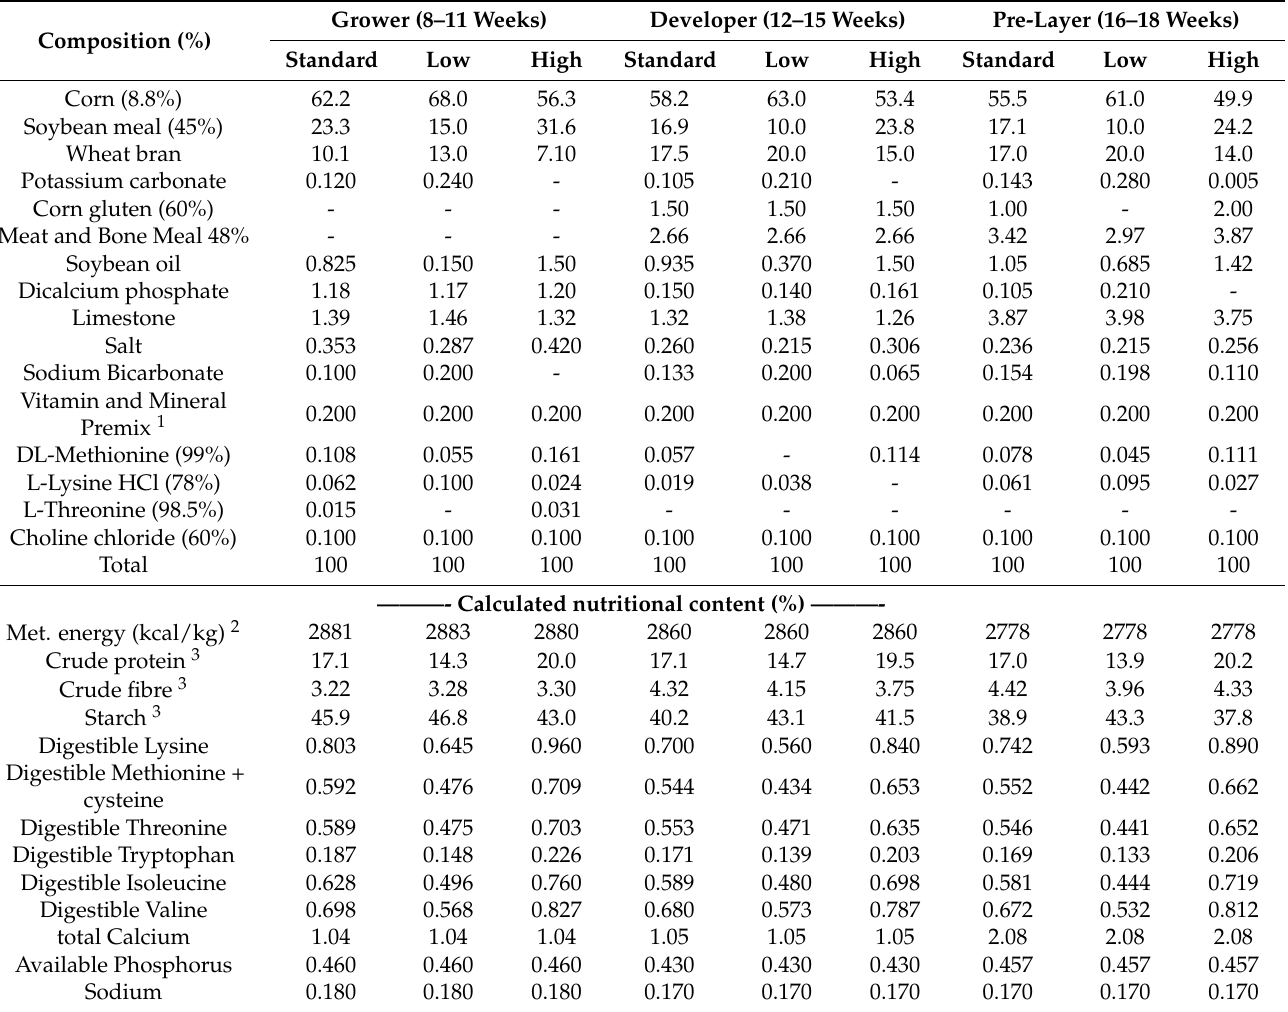
Table 1. Composition and nutritional content of experimental feeds in the rearing